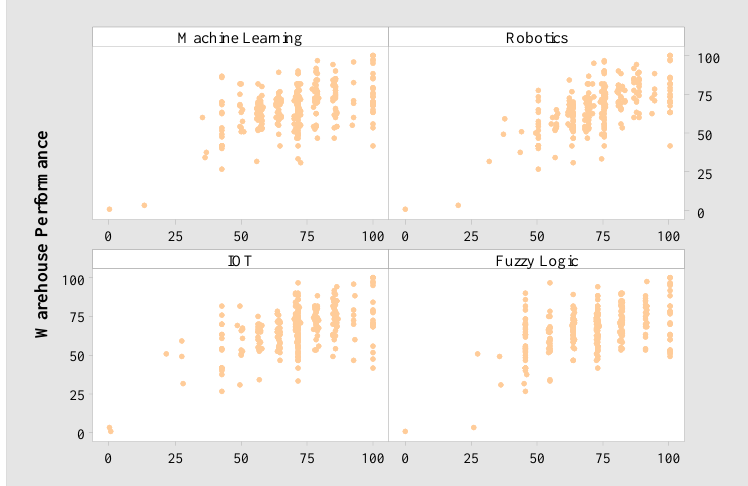
Source : Sample Survey, 2022